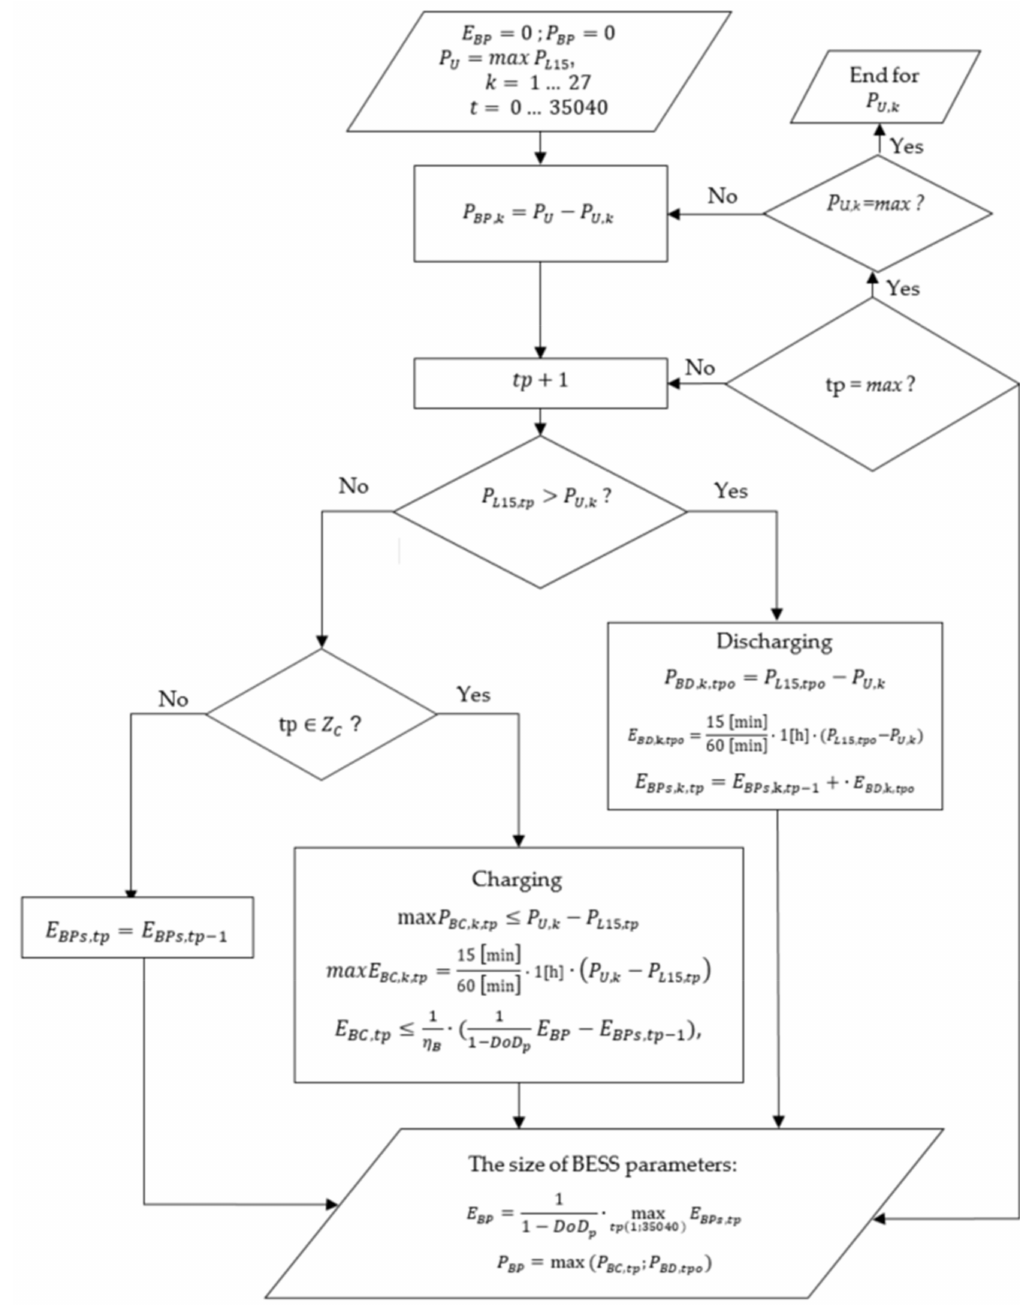
Figure 5. The block diagram of the